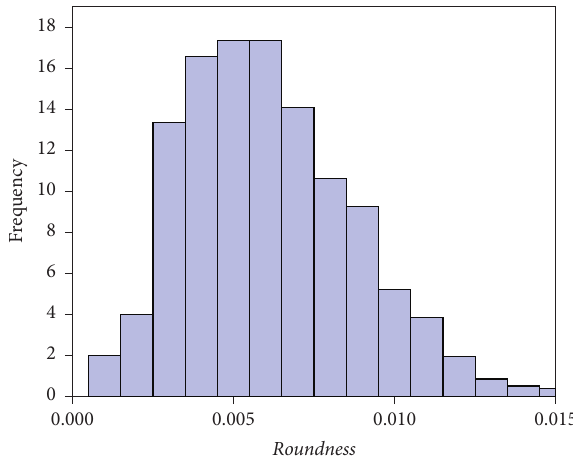
Figure 12: Statistical results of roughness